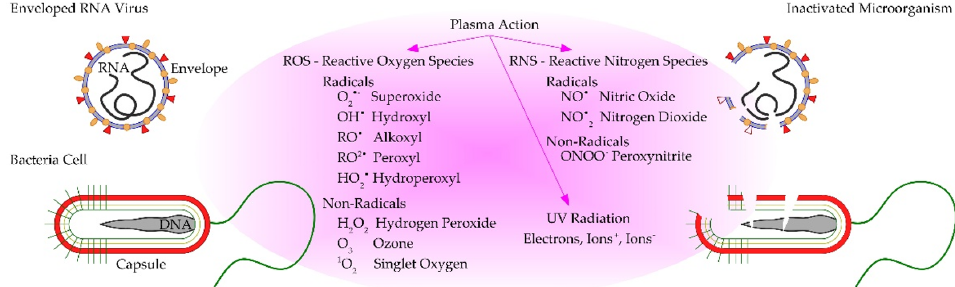
Figure 2. Schematic illustration of plasma inactivation of viruses and bacteria using CAPP treatment. Drug resistance and incurable bacterial infections are serious public health